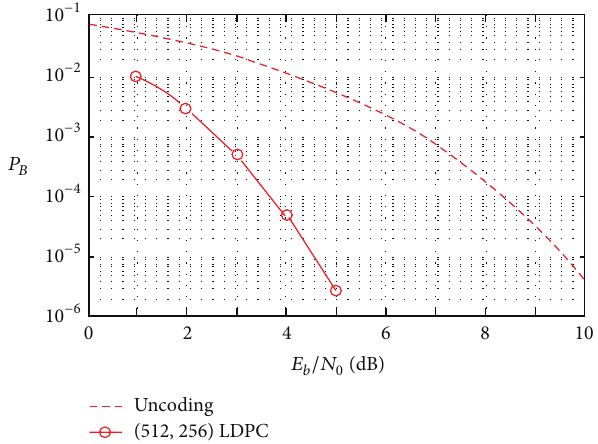
Figure 5: The bit error rate curve of the system (LDPC code) for the communication of a formation including three satellites.